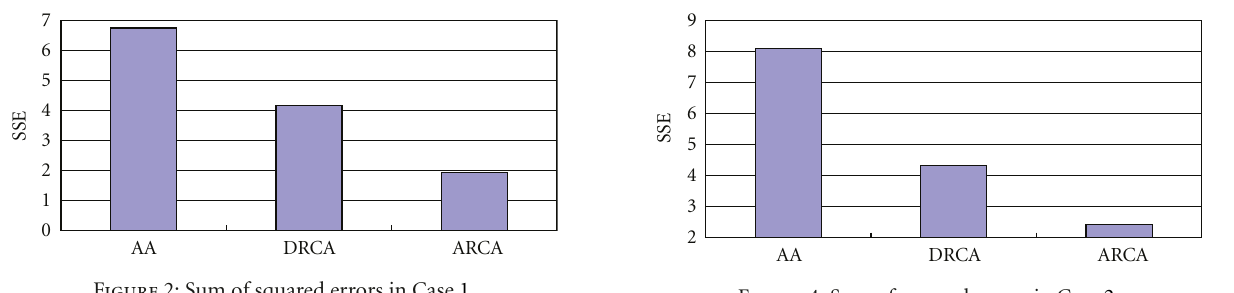
Figure 4: Sum of squared errors in Case